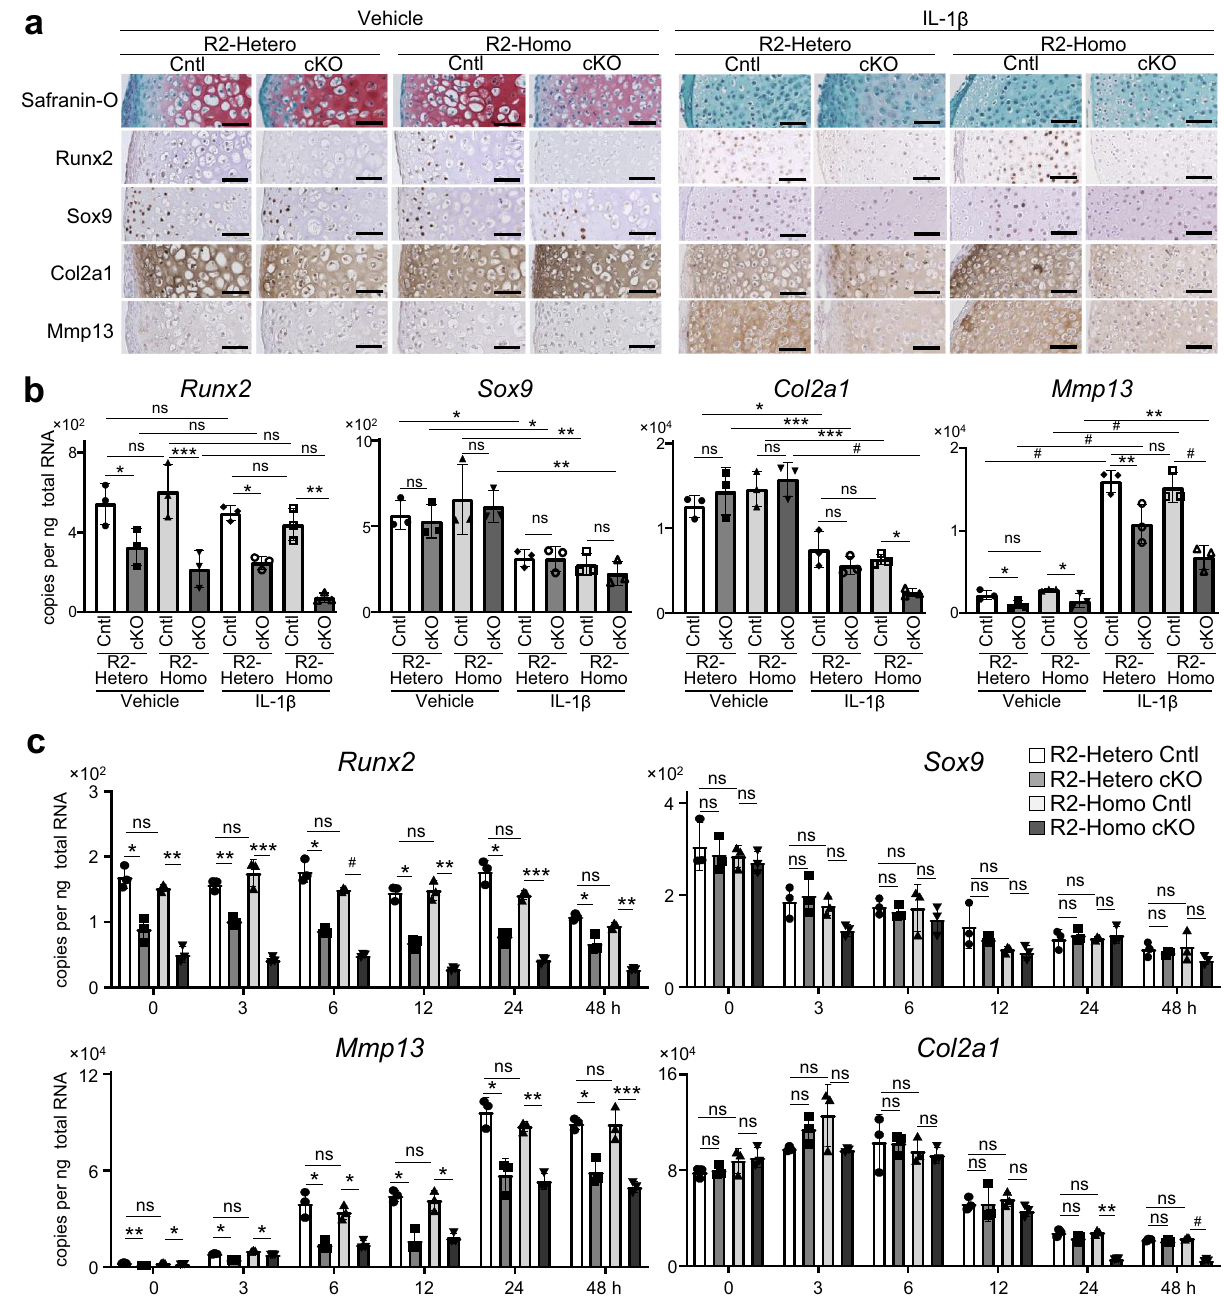
Fig. 4 | Homozygous and heterozygous Runx2-knockout femoral heads and primary chondrocytes with or without interleukin-1-beta (IL-1 β ). a Safranin-O stainingandimmunohistochemistryofRunx2,Sox9,Col2a1,andMmp13infemoral heads obtained from Runx2 fl /+ (R2-Hetero Cntl), Col2a1-Cre ERT2 ; Runx2 fl /+ (R2-Hetero cKO), Runx2 fl / fl (R2-Homo Cntl), and Col2a1-Cre ERT2 ; Runx2 fl / fl (R2-Homo cKO) P1 neonates, cultured with or without 1ng per mL IL-1 β for 2 weeks. Scale bars, 100 μ m. b mRNA levels of Runx2 , Sox9 , Col2a1 , and Mmp13 in femoral heads.